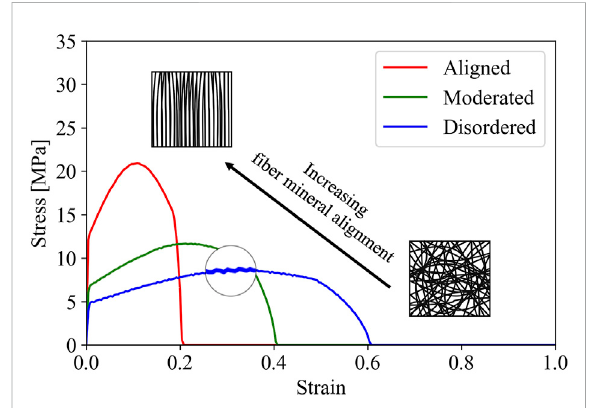
FIGURE 5 Theroleofthenumberof fi bersinmodifyingthestress-strain behavior of a fi brous microstructure. The greater the number of fi brous minerals within the microstructure, the higher is the stress at failure. The modeling realization refers to a microstructure characterized by a moderately disordered arrangement of the fi bers.Thepropertiesofthe fi brousmineralsusedformodelingthe role of the fi ber number are as those used for the modeling of Figure 4.